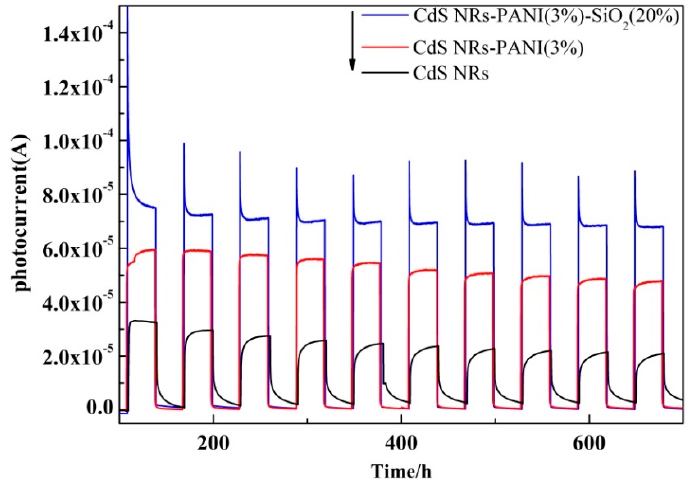
Figure 4. Transient photocurrent response of CdSNRs, CdS NRs-PANI (3%), and CdS NRs-PANI (3%)-SiO 2 (20%).